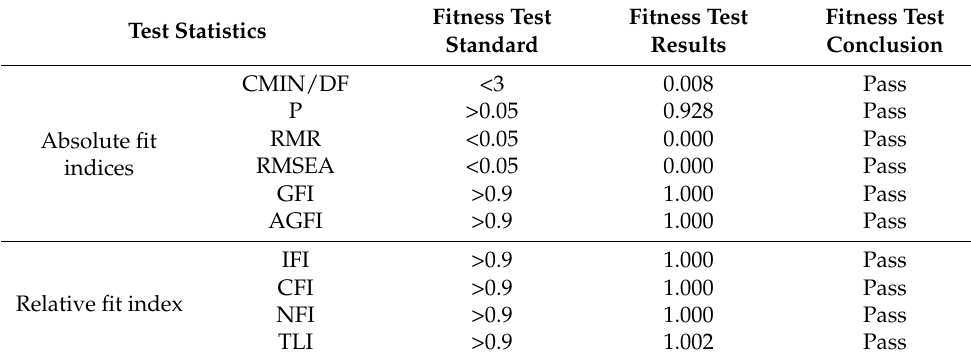
Table 12. Fitness results of the SEM.